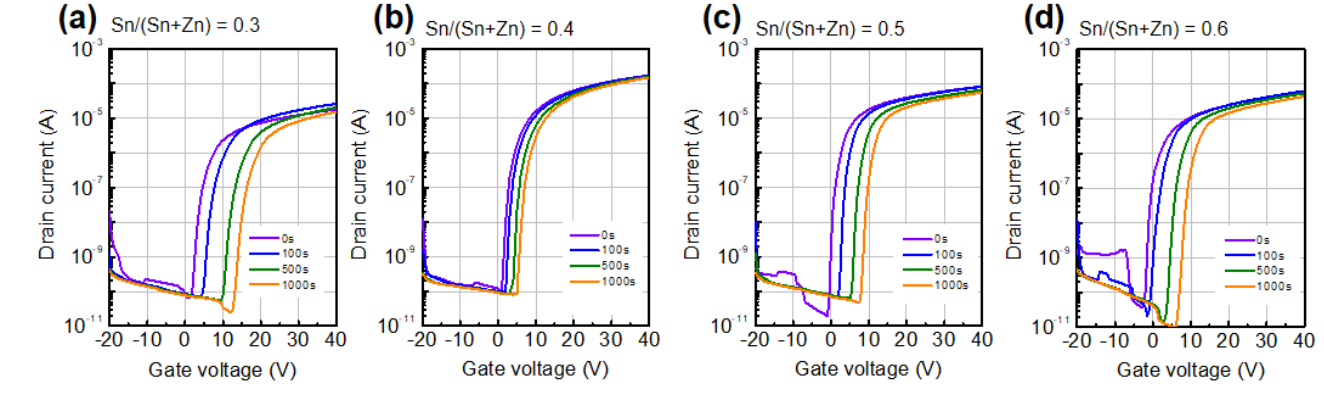
Figure 5. Transfer characteristics of ZTO TFTs with Sn/(Sn+Zn) ratios of ( a ) 0.3, ( b ) 0.4, ( c ) 0.5, and ( d ) 0.6 under PBS for specific stress times.